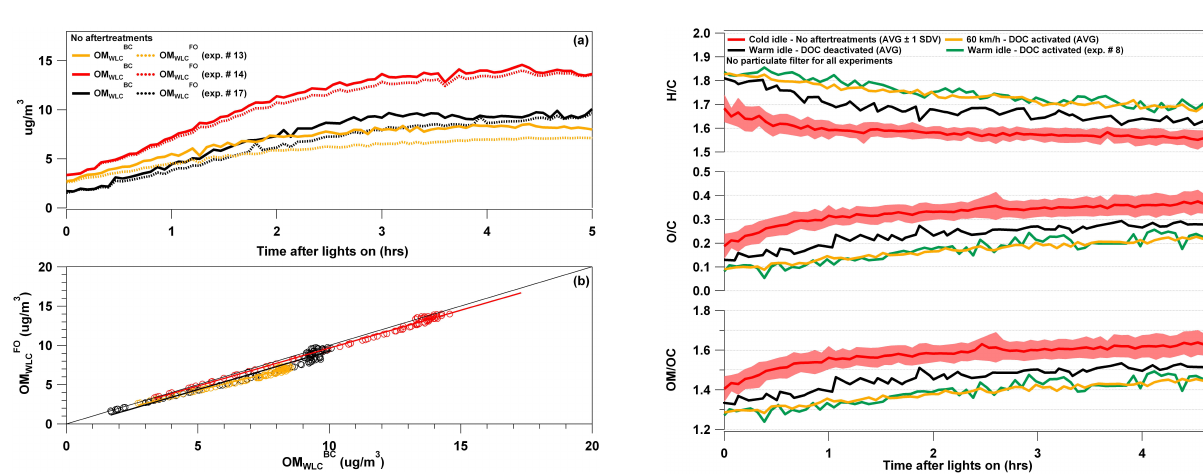
Fig. 8. Time series of average O/C and H/C atomic ratios and of av- erage OM/OC ratios. The shaded areas represent the average values ± one standard